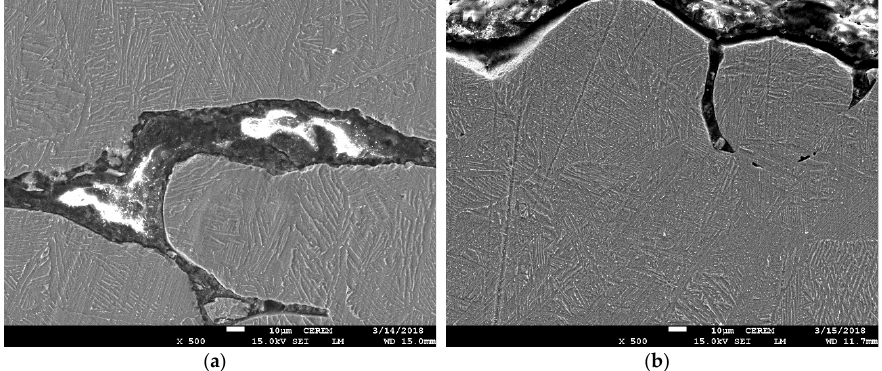
Figure 27. SEM images of 5-mm-thick cylindrical samples built without support: ( a ) 30-mm diameter; and ( b ) 17-mm diameter.